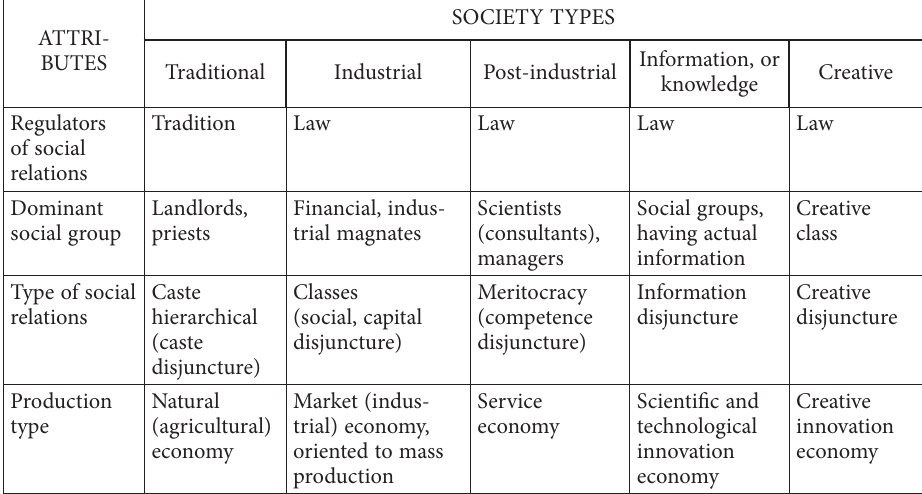
Table 1. Features of society types (source: created by author, according to Remeika & Čepaitis, 2007)